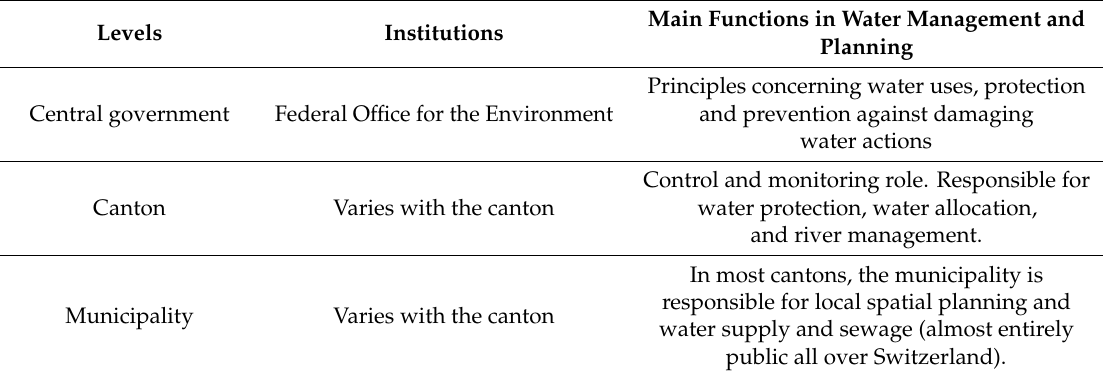
Table 3. The main institutions and their functions in water management and planning in Switzerland. Levels Institutions Central government Federal O ffi ce for the Environment Canton Varies with the canton Municipality Varies with the canton